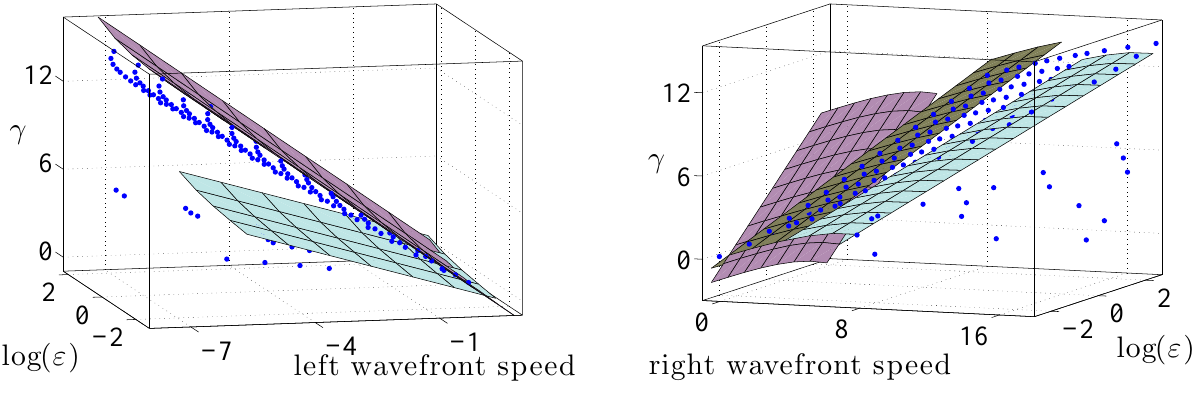
Figure 3. Numerical data compared to analytical estimates. The left wave speed is close to the low parameter estimate for all parameter values. In contrast, the right wave speed is far from the low parameter estimate, and fairly close to the high parameter estimate. While the behaviour corresponds to the analysis, the behaviour of θ is different to expectations. In the left wavefront speed, the darker surface is the low −√ (cid:112) 1 + ε 1 − µ 2 ; The lighter surface is the high parameter estimate: (1 − p ) γ/ 2 − parameter estimate: γ/ 2 In the right wavefront speed, the lighter surface is the high parameter estimate: (1+ p ) γ/ 2+ surface is a less extremal estimate, with p cos φ = 1 , giving the surface as γ + √ (cid:112) 1 + ε 1 − µ 2 . The parameter is µ = 0 . 95 , giving p ≈ parameter estimate: γ/ 2 + of the original Schnakenberg reaction-diffusion-convection equation (2) using NAG D03PCF. In the individual runs, the reactants are initially at steady state: ( u, v ) = (0 , 0) , with a small disturbance at x = 0 . The boundaries are held at zero derivative: u x = 0 , v x = 0